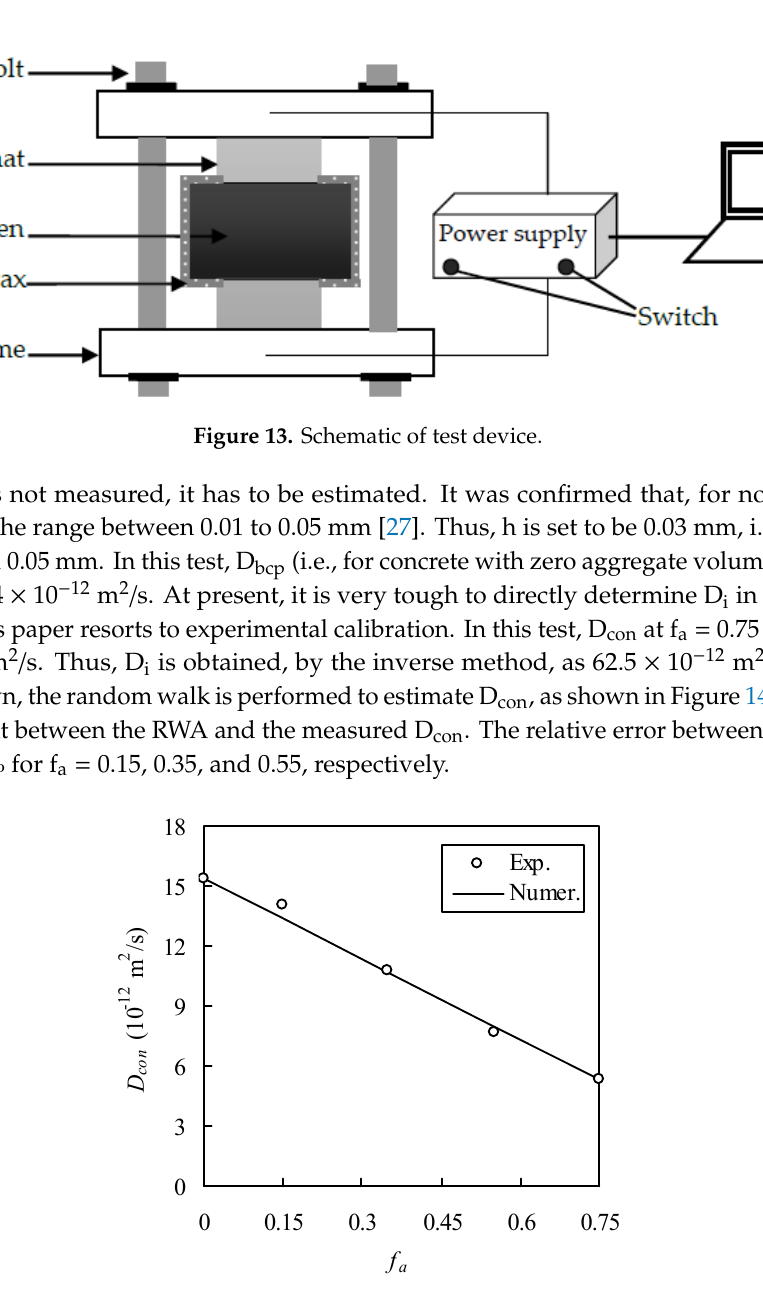
Figure 14. Comparison of numerical method with self-conducted experimental results.